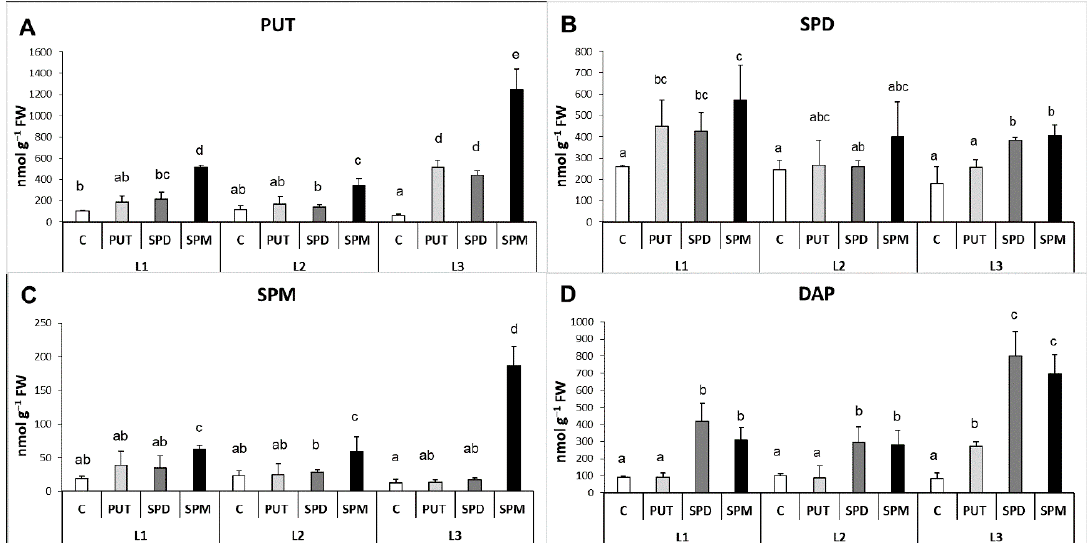
Figure 5. Effect of different light intensities on the polyamine pattern ( A : PUT: putrescine, B : SPD: spermidine, C : SPM: spermine, D : DAP: 1,3-diaminopropane) in the roots of plants grown under 16 h/8 h day/night light period with different light intensity conditions: 500 (elevated light: L1), 250 (medium light: L2) and 50 (low light: L3) μ mol m 2 s − 1 LED light after 7 days of 0.3 mM exogenous putrescine (PUT), spermidine (SPD) or spermine (SPM) treatments or without any treatment (C). PUT: putrescine, SPD: spermidine, SPM: spermine, DAP: 1,3-diaminopropane. Data represent mean values ± SD. Different letters indicate significant differences at p ≤ 0.05 level, among all the values of the given compounds.